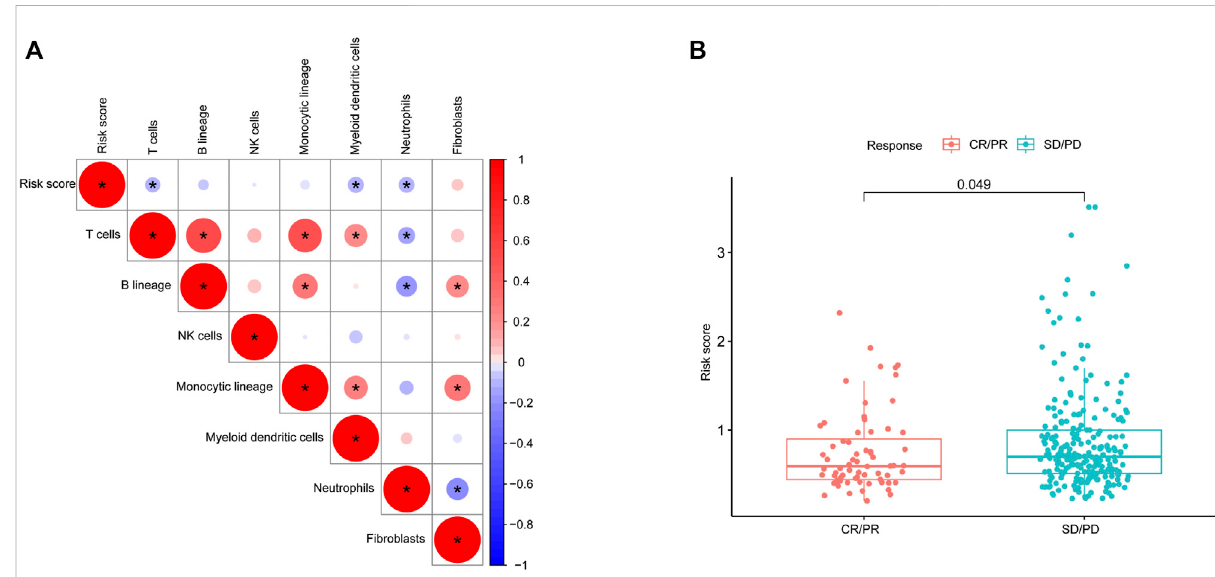
FIGURE 8 Microenvironmental characteristics of lung cancers. (A) , Correlation between the risk score and microenvironment-related cell types. (B) , Risk score distribution between patients with different treatment